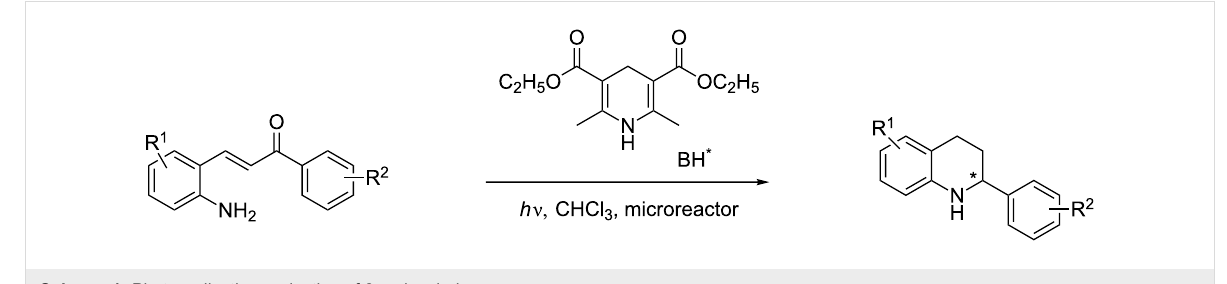
Scheme 1: Photocyclization–reduction of 2-aminochalcone.